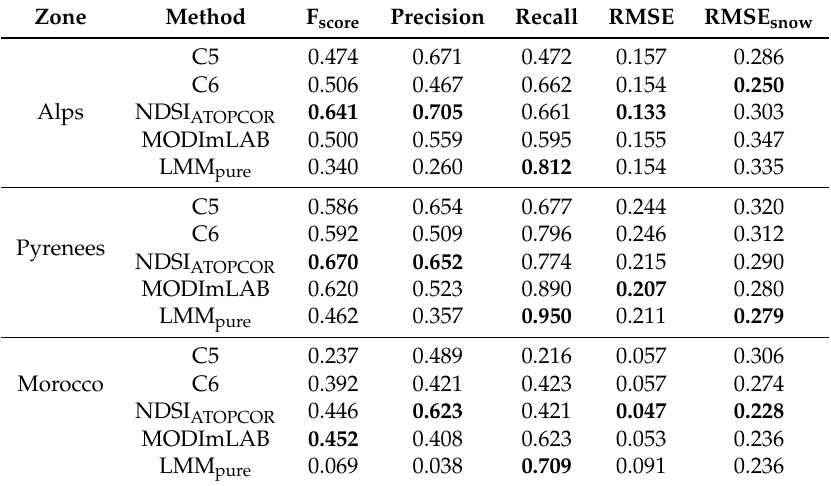
Table 2. Average binary and fractional metrics values for the three areas of interest compared at 250 m (range [0–1]). An efficient approach will show high scores for binary metrics (F score , Precision, and Recall) and low values for RMSE and RMSE snow